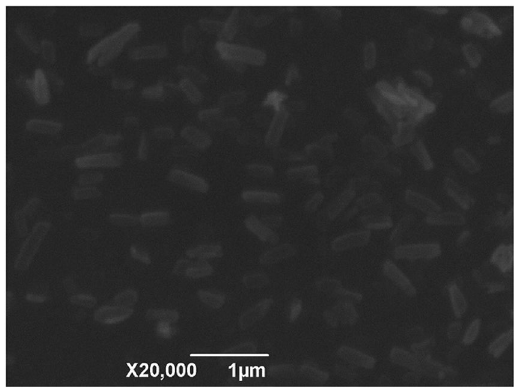
Figure 2. SEM photomicrograph of Cyx nanoparticles ( × 20,000).